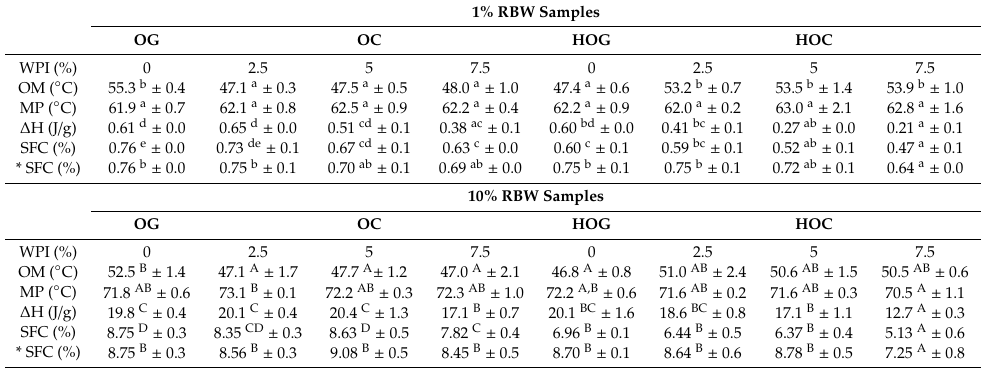
Figure 4. DSC melting thermograms of: ( a ) OG and ( b ) HOG made with 1 and 10% RBW. Arrows show the onset of melting and melting peak. The straight and dotted lines represent samples made with different RBW concentrations. Table 4. Thermal properties [onset of melting (OM), melting point (MP), enthalpy ( ∆ H)], and solid fat content (SFC and normalized * SFC) of the colloidal